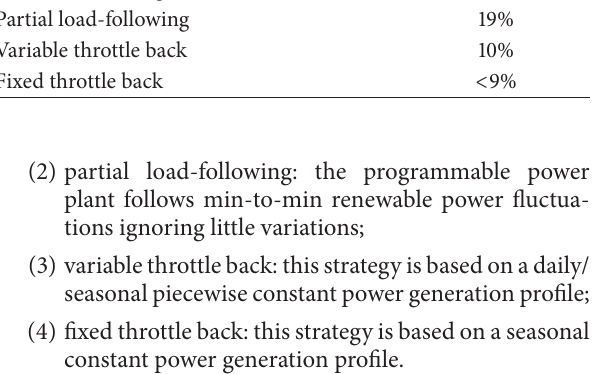
Table 1: Threshold indicators for production strategies. Productive strategy